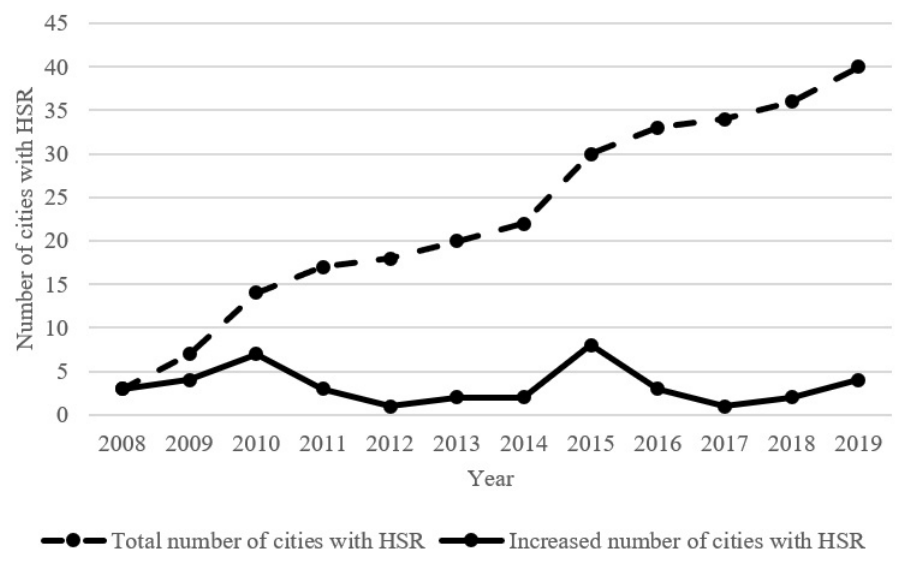
Figure 2. Changes in the number of cities with HSR in the YRD